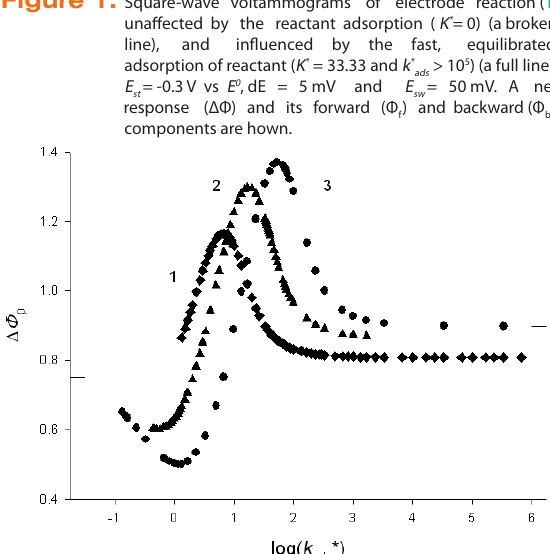
Figure 2. Dependence of dimensionless net peak current of square- wave voltammograms of electrode reaction (1) on the logarithm of dimensionless rate constant of the reactant adsorption. K* = 3.33 (1, ♦ ), 10 (2, ▲ ) and 33.33 (3, ● ). All other parameters are as in Fig.